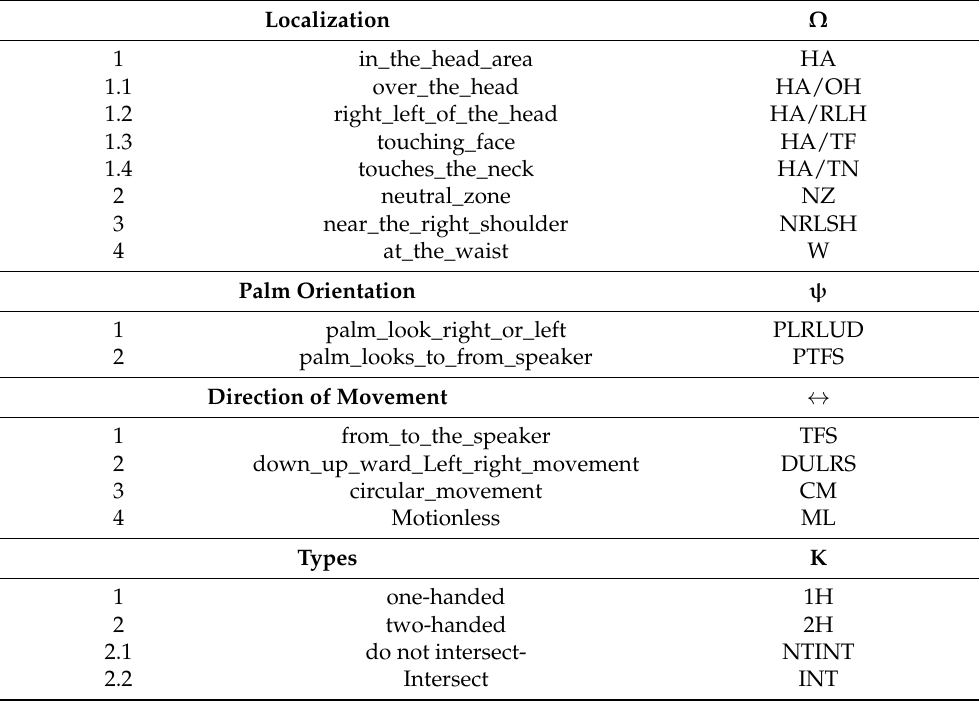
Table 1. The basic parameters of Kazakh Sign Language, received at